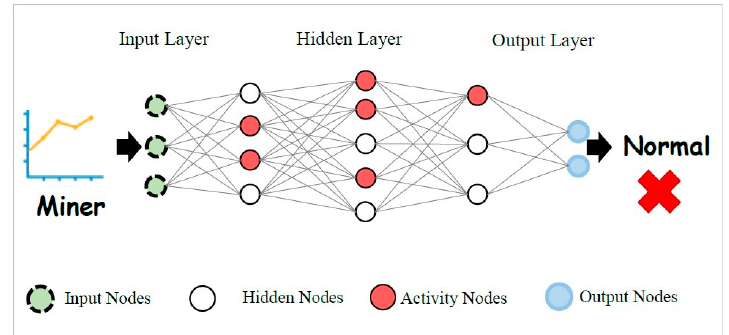
Figure 13. ANN model failure prediction.